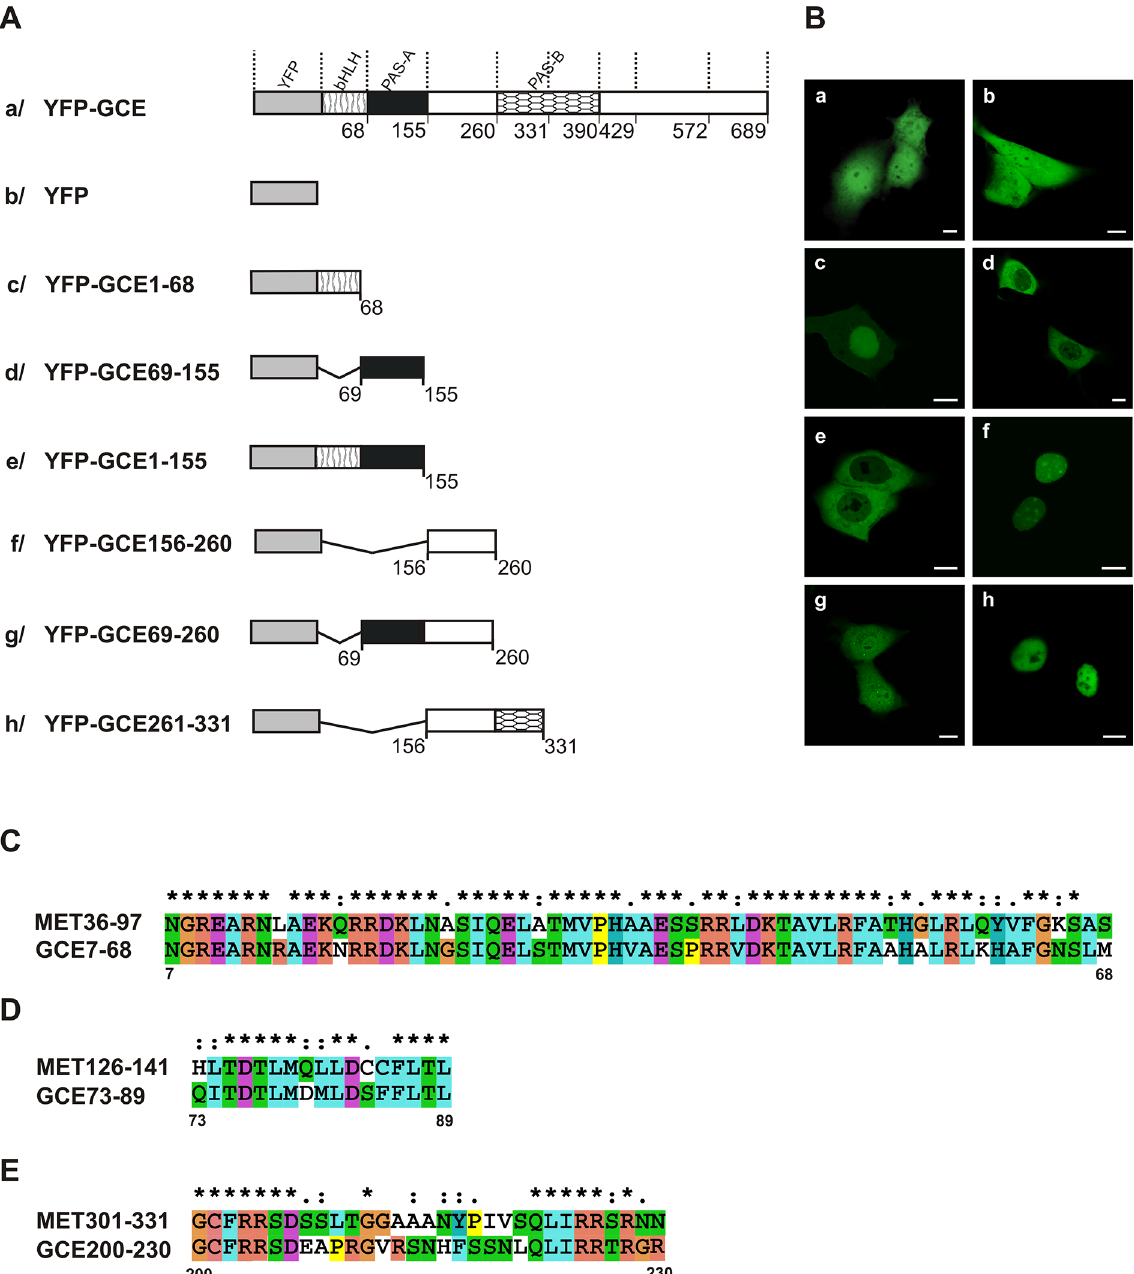
Fig 1. Subcellular distribution of the GCE mutants. Experiments identifying NLS and NES motifs in GCE, using full-length GCE and a series of deletion mutants tagged with YFP revealed differentiated localization of truncated proteins. The subcellular localization of the expressed proteins was analyzed by confocal microscopy 20-24h after the transfection of COS-7 cells. (A) Schematic representation of the GCE and deletion mutants. Regions of GCE are depicted using different patterns. The length of each domain in the diagram is arbitrary. (B) Representative images (single confocal plane) of the subcellular distribution of the GCE derivatives. Bar, 10 μ m. (C) ClustalX alignment of the MET36-97/GCE7-68 encompassing bHLH domain. (D) ClustalX alignment of the MET126-141/GCE73-89 encompassing NES in PAS-A domain. (E) ClustalX alignment of the MET301-331/GCE200-230 from area linking PAS-A with